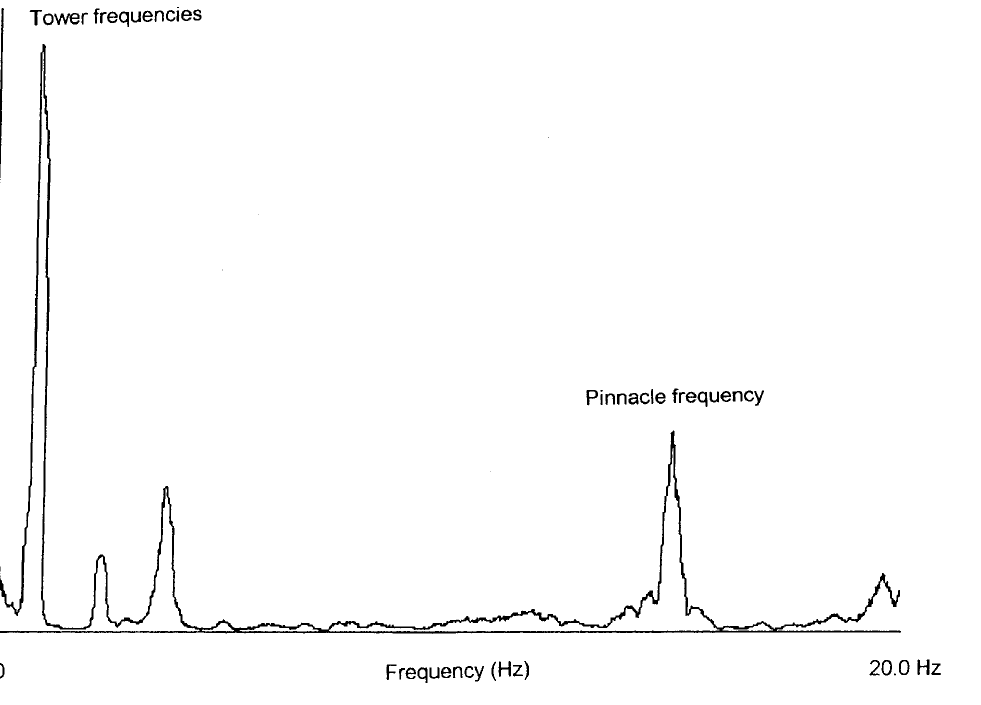
Fig. 4. Autospectrum measured for a pinnacle on the clock tower.